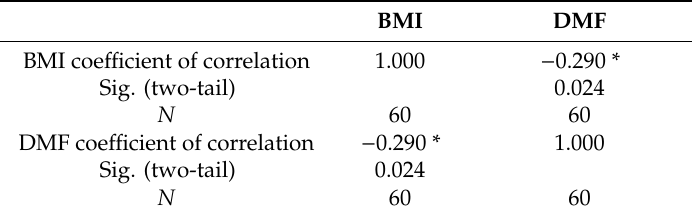
Table 8. Data related to the correlation between BMI and DMF evaluated in normal weight patients.